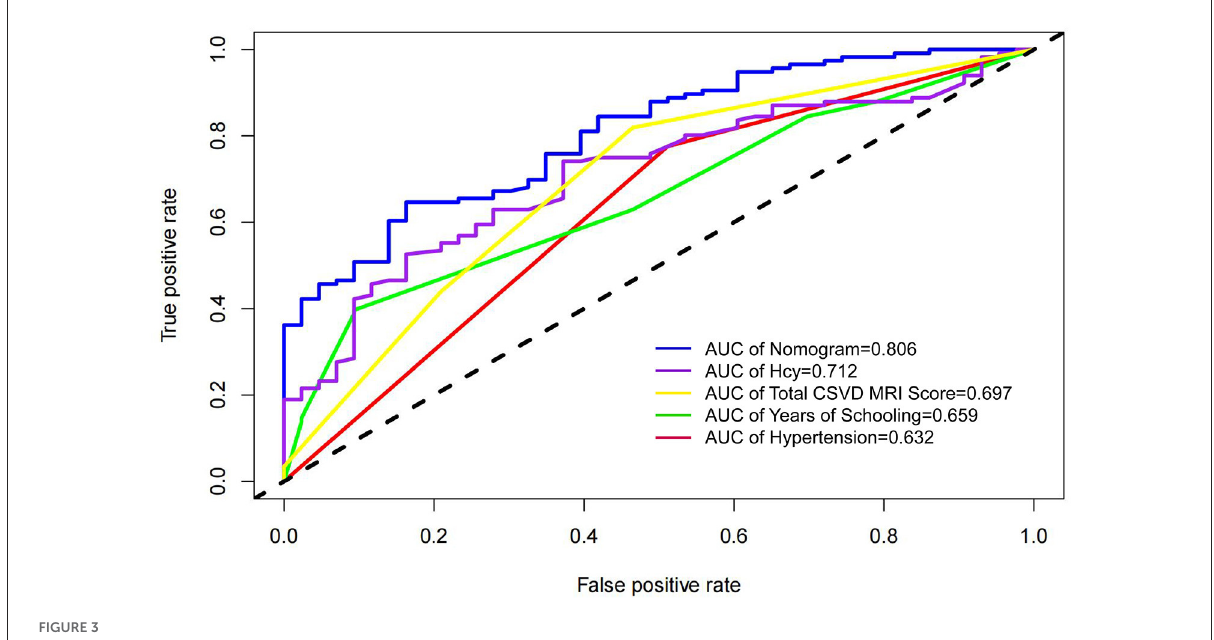
FIGURE3 ROC curves of independent risk factors and nomogram.